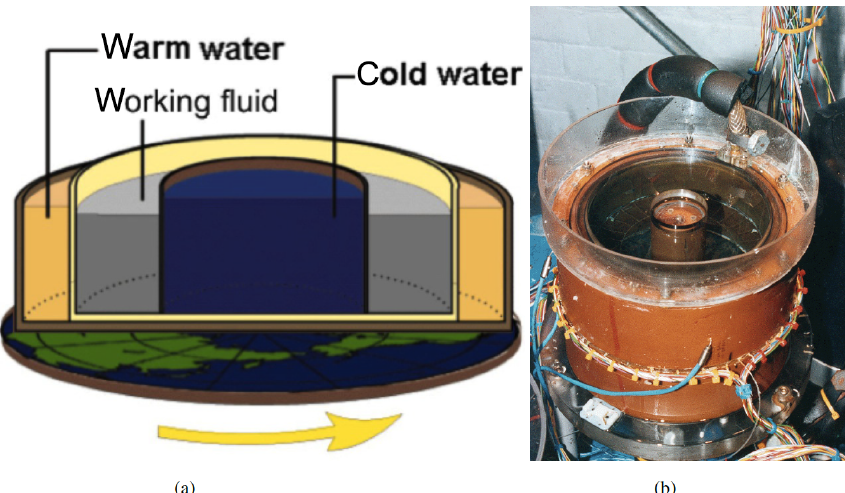
Figure 5. Schematic layout of the thermally driven, rotating annulus experiment (a) as a vehicle for the study of rotating, stratified flows, with (b) a photograph of a typical apparatus in the laboratory, clearly showing the metallic inner and outer cylinders and connections to heat exchangers for maintaining the temperature of the outer wall and a ring of thermocouple junctions to measure temperatures in the interior.